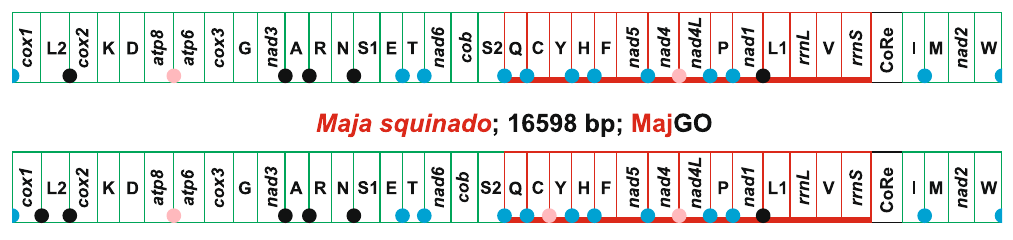
Figure 2. The mitochondrial genomes of Maja crispata and Maja squinado . The MajGO gene order is depicted and linearized starting from cox1 . Graphical representation of the mtDNAs and nomenclature of genes as in Fig. 1. A blue circle marks an intergenic spacer assumed to be linked to the genomic rearrangement. A black circle marks an intergenic spacer supposed to be the result of a DNA slippage, during the genome replication. A pink circle marks an overlap between adjacent genes. The α -strand genes are green-boxed, while those of β -strand are underlined and